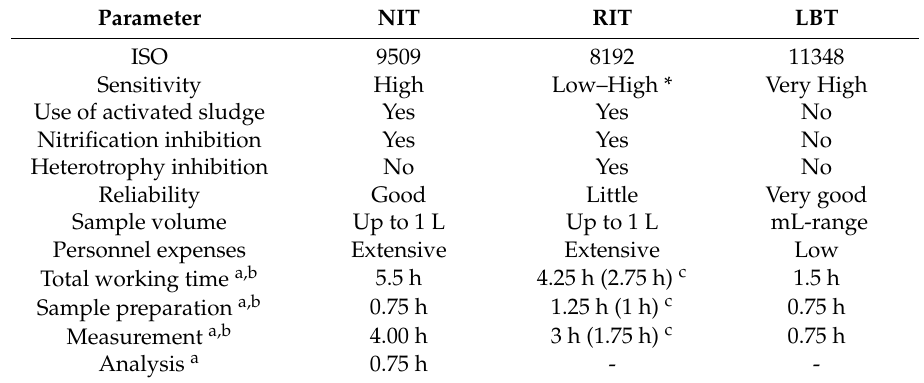
Table 2. Comparison of three bacterial inhibition tests in terms of workload, applicability and